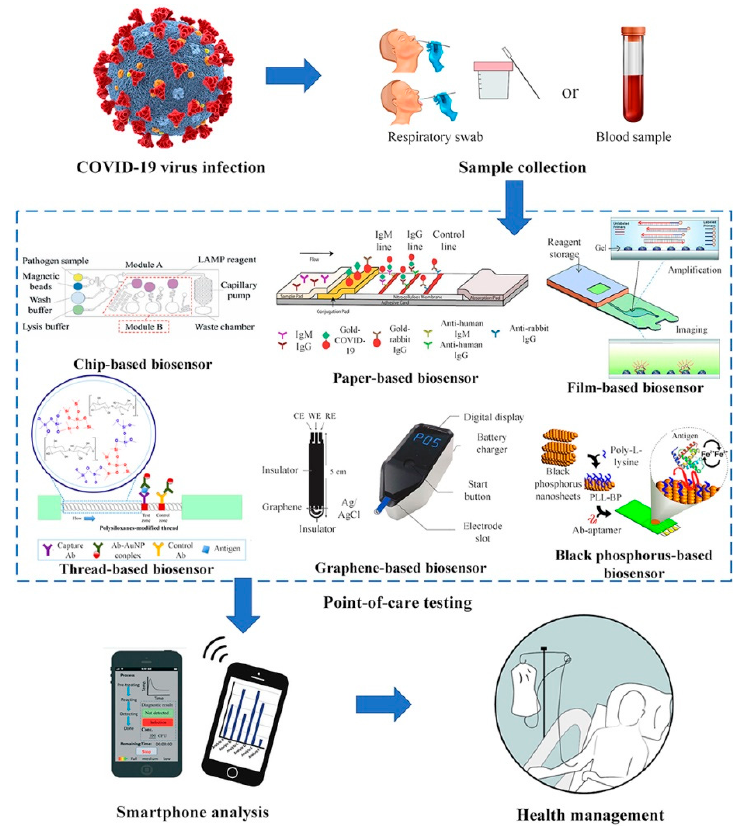
Figure 3. Point-of-care (POC) for COVID-19. Reprinted with permission from Choi, J. et al. Development of Point-of-Care Biosensors for COVID-19. Front Chem 8: 517. Copyright (2019) Frontiers in Chemistry [214].